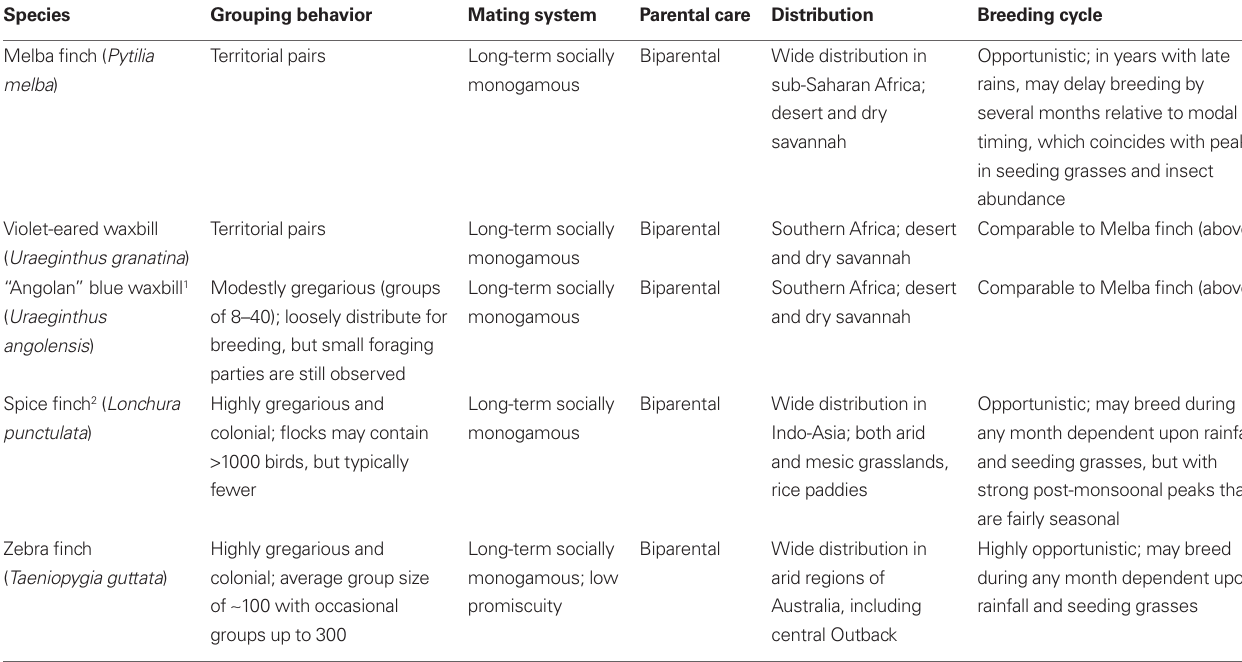
Table 1 | Behavioral and ecological characteristics of estrildid finch species that have been used for studies of grouping behavior. For relevant references, see footnote